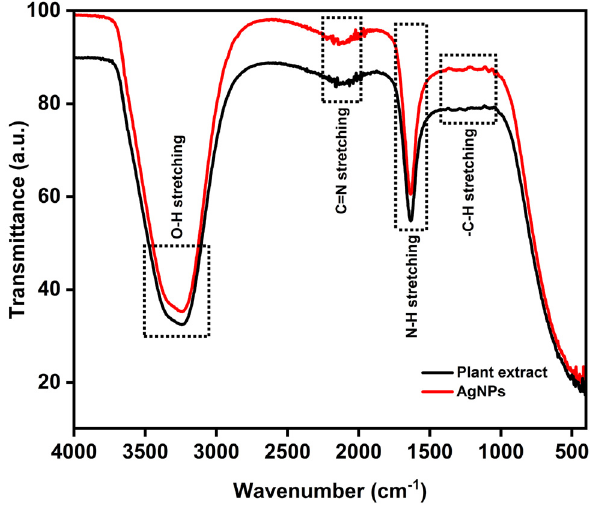
Figure 3: FTIR characterization of the Pelargonium extract and synthesized AgNPs indicating the various functional groups.